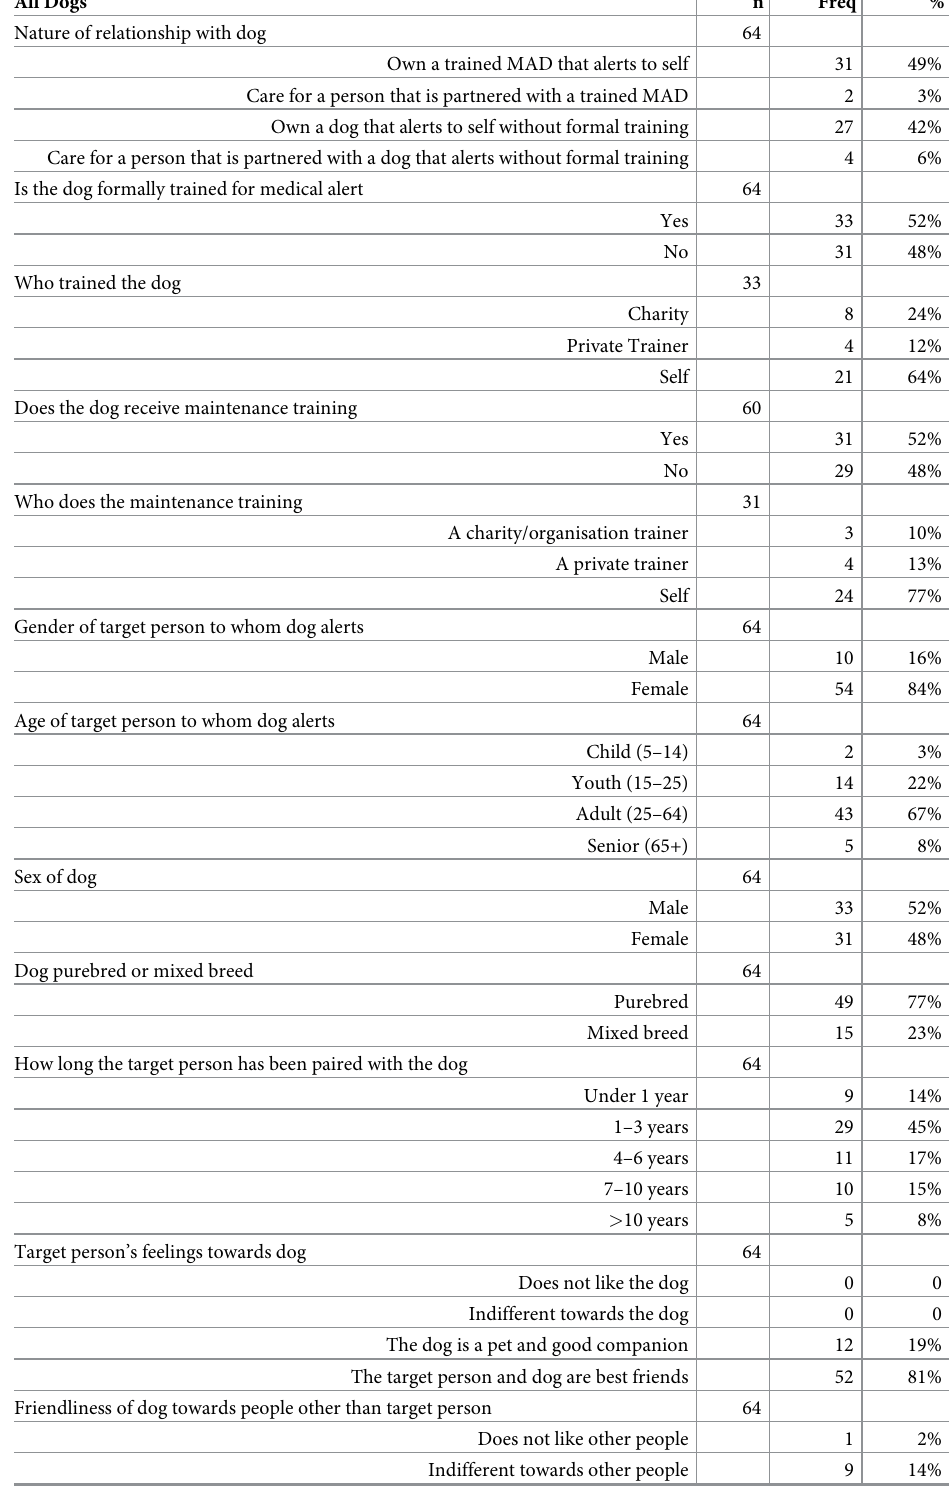
Table 1. Demographic variables of Medical Alert Dogs and the target person to whom the dog alerts. All Dogs n Freq % Own a trained MAD that alerts to self 49% Care for a person that is partnered with a trained MAD 2 3% Own a dog that alerts to self without formal training 27 42% Care for a person that is partnered with a dog that alerts without formal training Is the dog formally trained for medical